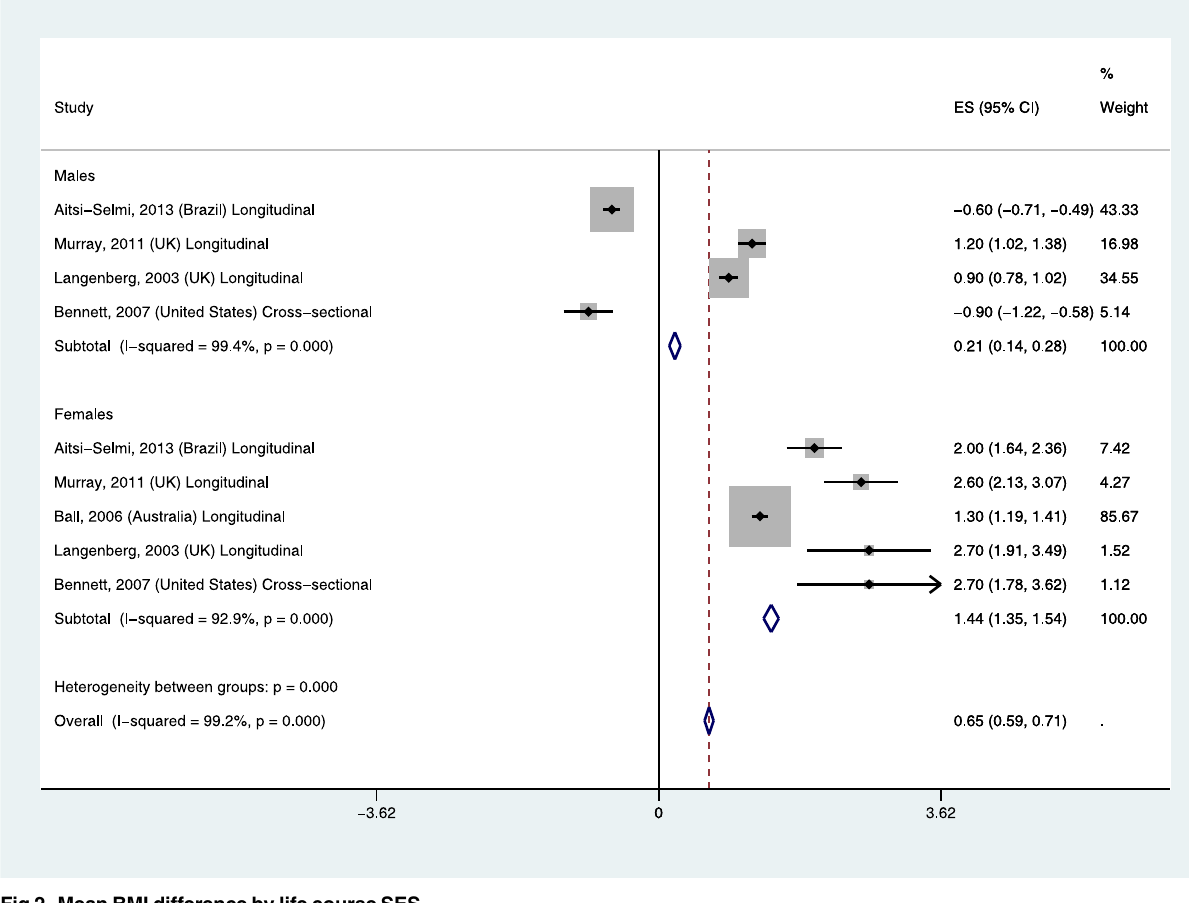
PLOS ONE | https://doi.org/10.1371/journal.pone.0177151 May 16,